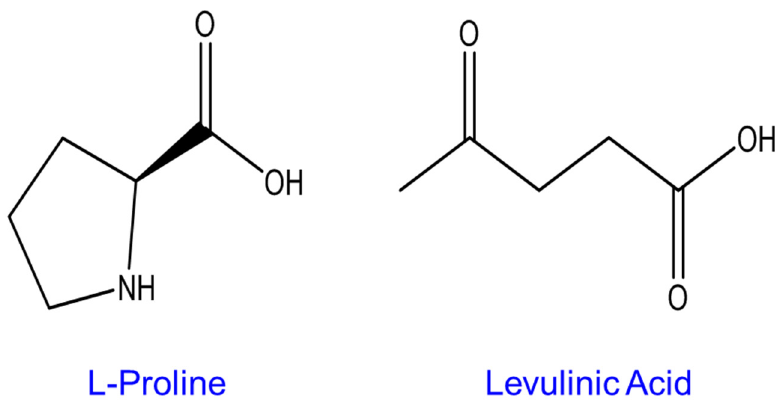
Figure 1. Chemical structures of L-Proline and Levulinic Acid.